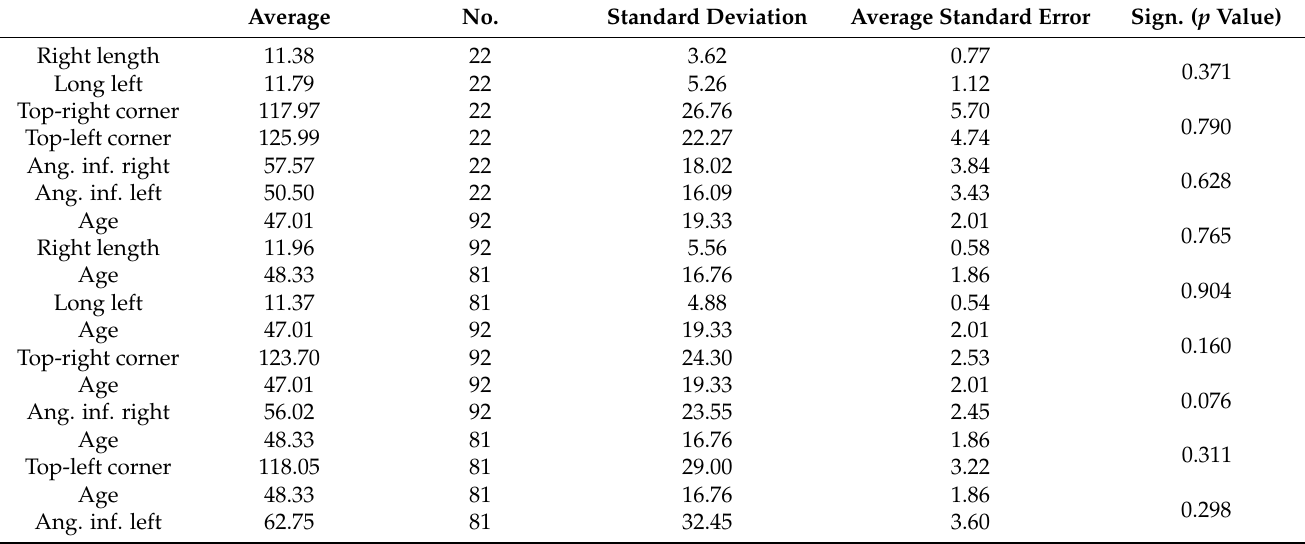
Table 4. Student’s t